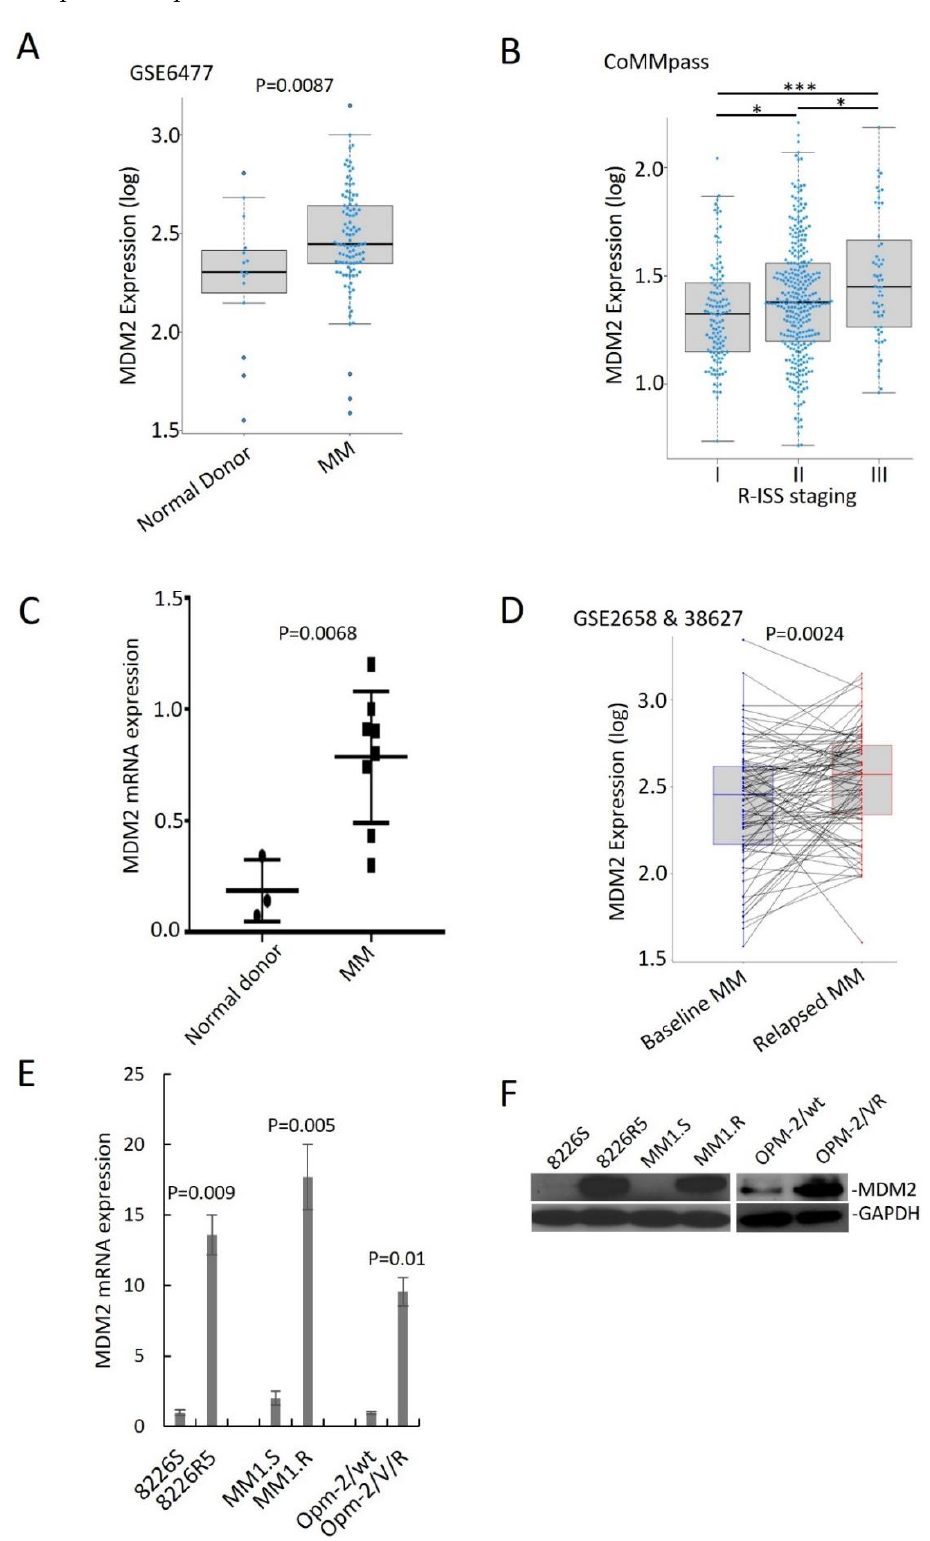
Figure 1. MDM2 overexpression is associated with advanced staging, disease relapse and poor out- comes in MM patients. ( A ) MDM2 expression in normal donor, newly diagnosed MM, and relapsed MM (GSE6477; ND n = 15, newly diagnosed MM n = 73). ( B ) Baseline MDM2 expression in different clinical stages of MM (CoMMpass; R-ISS-I n = 128; R-ISS-II n = 318; R-ISS-III n = 60). R-ISS-I vs. R- ISS-II, p = 0.029; R-ISS-II vs. R-ISS-III, p = 0.01, R-ISS-I, vs. R-ISS-III, p < 0.0001. ( C ) qRT-PCR quanti- fication of MDM2 mRNA from CD138+ cells of three normal donors and eight MM patients. Results are presented as mean ± SD of three independent experiments. ( D ) MDM2 expression before and